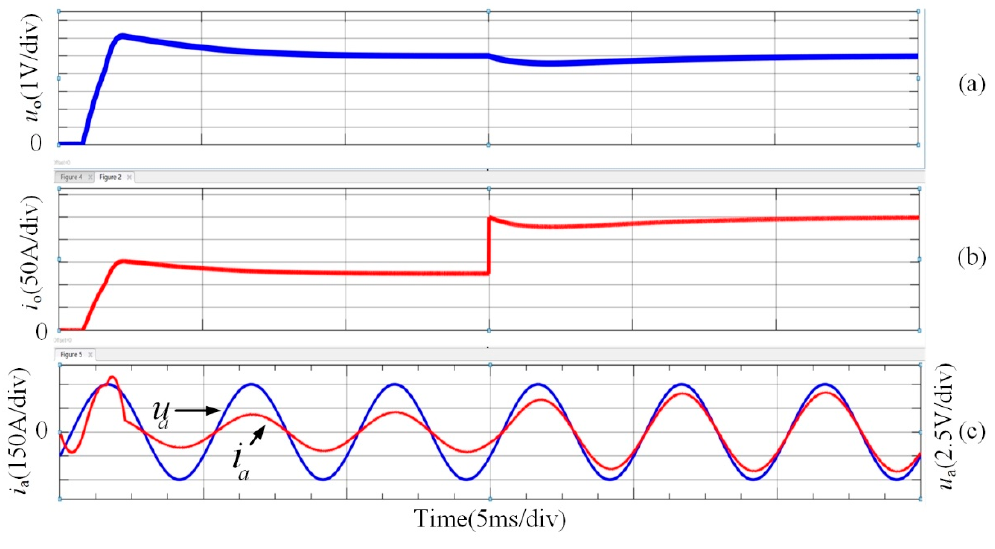
Figure 11. Simulation waves of the no beat control algorithm: ( a ) Voltage wave; ( b ) current wave; ( c ) A-phase voltage and current waves.